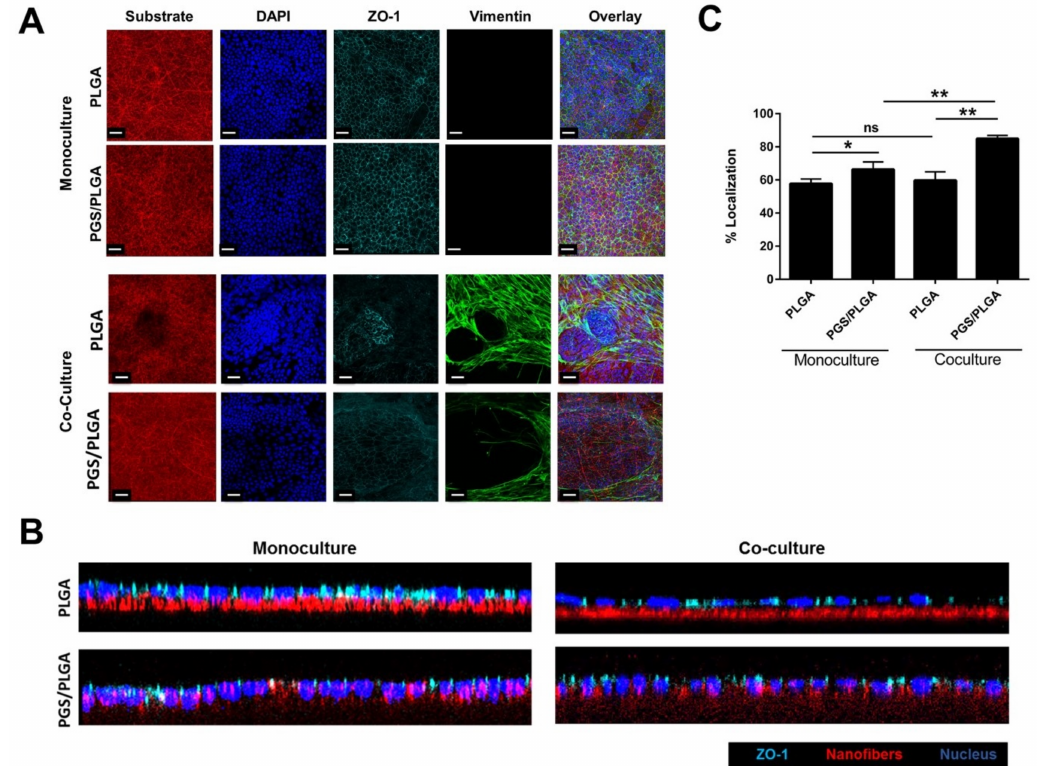
Figure 7. PGS/PLGA scaffolds and co-culture promote apical polarization of epithelial cells. ( A ) SIMS cells were cultured alone or co-cultured with NIH 3T3 cells on PLGA or PGS/PLGA scaffolds (red) for 7 days, stained for DAPI (blue), immunostained for vimentin (green) and ZO-1 (cyan), and confocal stacks were collected (the XY maximum projections are shown). Scale, 30 µ m, ( B ) XZ slice of cells cultured on PLGA and PGS/PLGA nanofiber scaffolds. Nanofibers (red), DAPI (blue), ZO-1 tight junction protein (cyan), ( C ) Quantification of the average % apical localization of tight junction protein, ZO-1, in SIMS cells on each scaffold is shown with and without cultured NIH 3T3 cells. Data are means ± SD ( n = 4). NS: not significant, * p < 0.05, ** p <